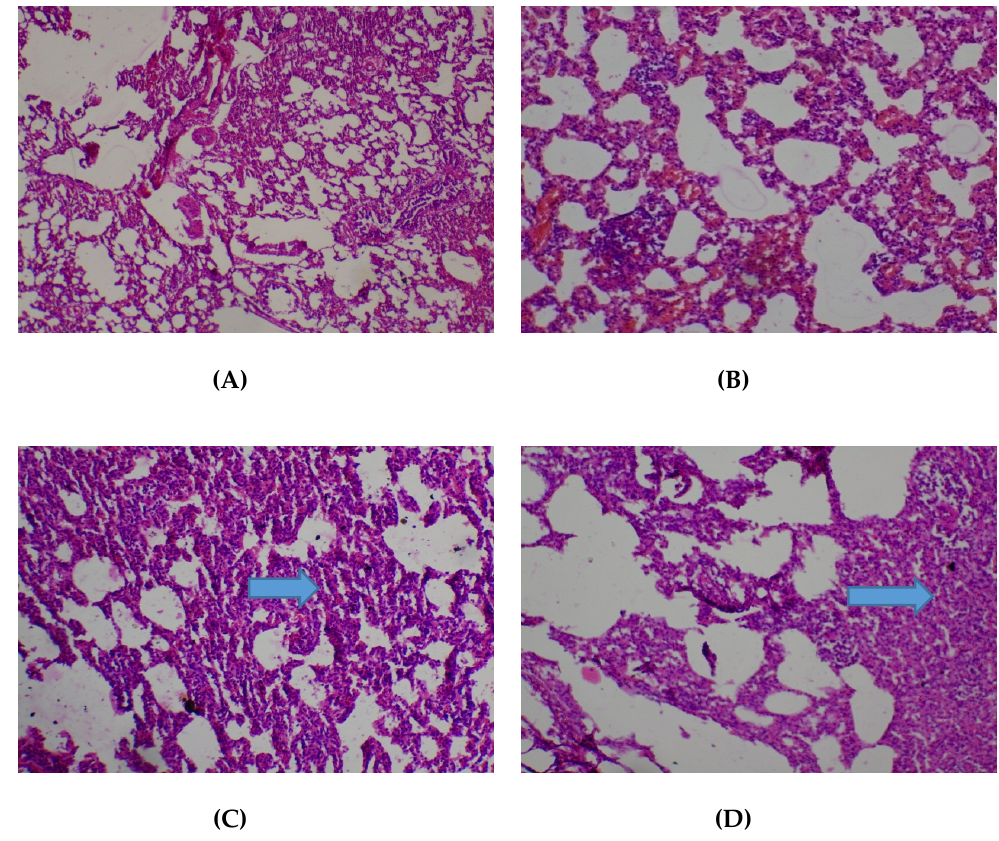
Figure 3. Histopathological presentation of rat lungs. ( A ) represents the control group treated with distilled water (Normal); ( B ) represents the group treated with 80 mg/kg T. occidentalis extract (interstitial hemorrhage) — See Arrow; ( C ) represents the group treated with 400 mg/kg T. occidentalis extract (interstitial inflammation) — See Arrow; and ( D ) represents group treated with 2000 mg/kg T. occidentalis extract (interstitial inflammation) — See Arrow ( × 400). The histologic section of lung tissue reported as normal ( A ) show air filled alveolar spaces with minimal surrounding interstitial inflammation or hemorrhage.